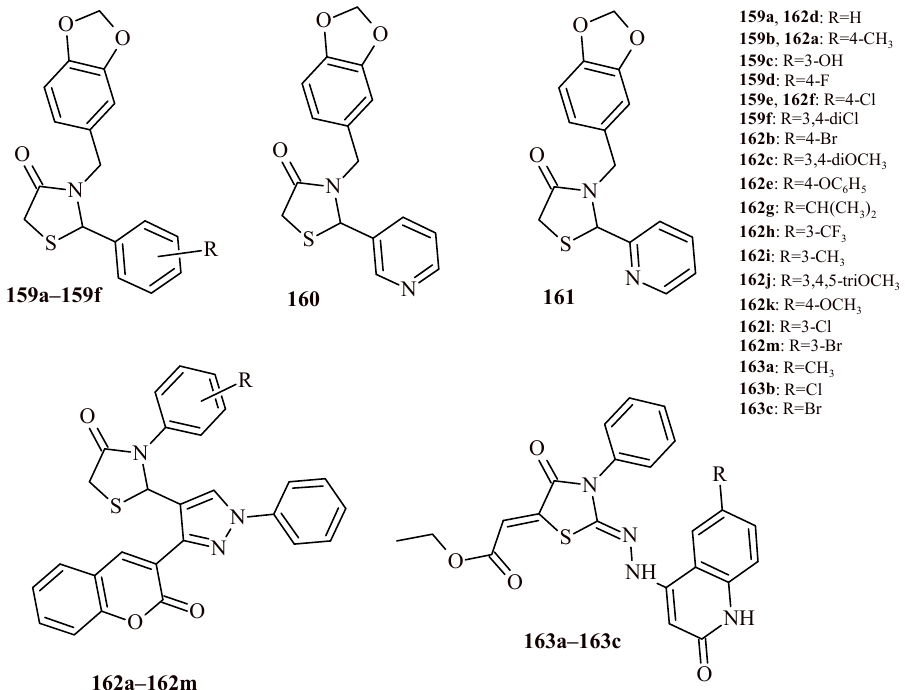
Figure 59. The structures of thiazolidine-4-one as effective AChE, hCA and urease